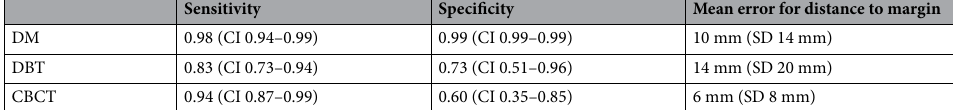
Table 2. The pooled sensitivity, specificity and mean measurement errors for the smallest distance of delineated microcalcifications to the resection margin for digital mammography (DM), digital breast tomosynthesis (DBT) and cone-beam computed tomography (CBCT) ( CI confidence interval, SD standard deviation).